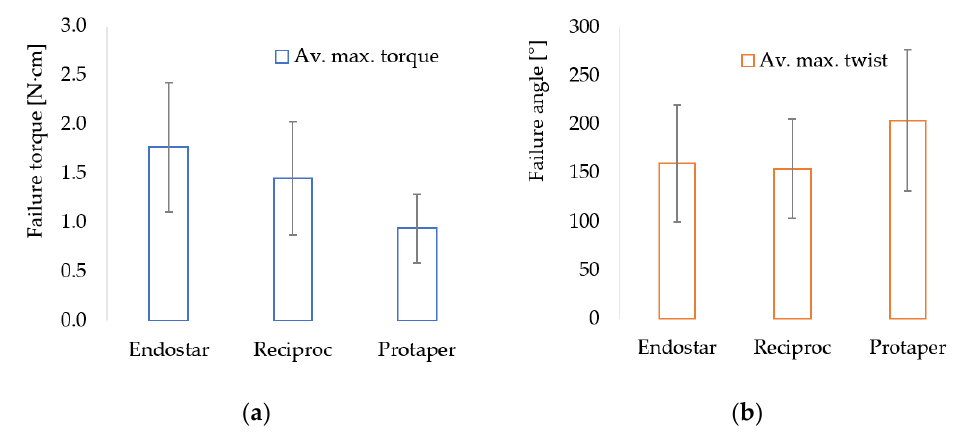
Figure 6. ( a ) The maximum (failure) torsion torque T max and ( b ) the twisting angle θ max at fracture for the instruments of the three groups: Endostar, Reciproc, and Protaper.